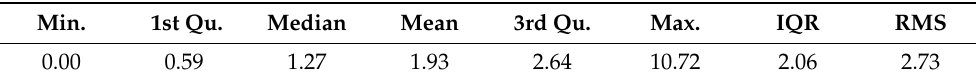
Figure 13. M1 model measured via HD. ( a ) The original model from the CT, ( b ) the scanned model with the proposed system, and ( c ) the quality map between the scanned and original models. Table 2. HD statistics results were obtained from the reconstruction model comparison (values in